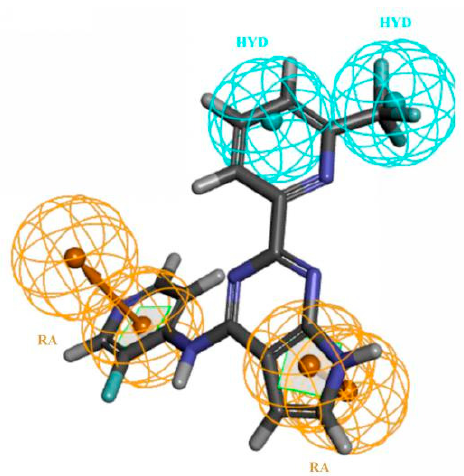
Figure 4. Pharmacophore model B10 superposed with BMS22 (aromatic ring centers in orange balls; hydrogen bond acceptors in blue balls).